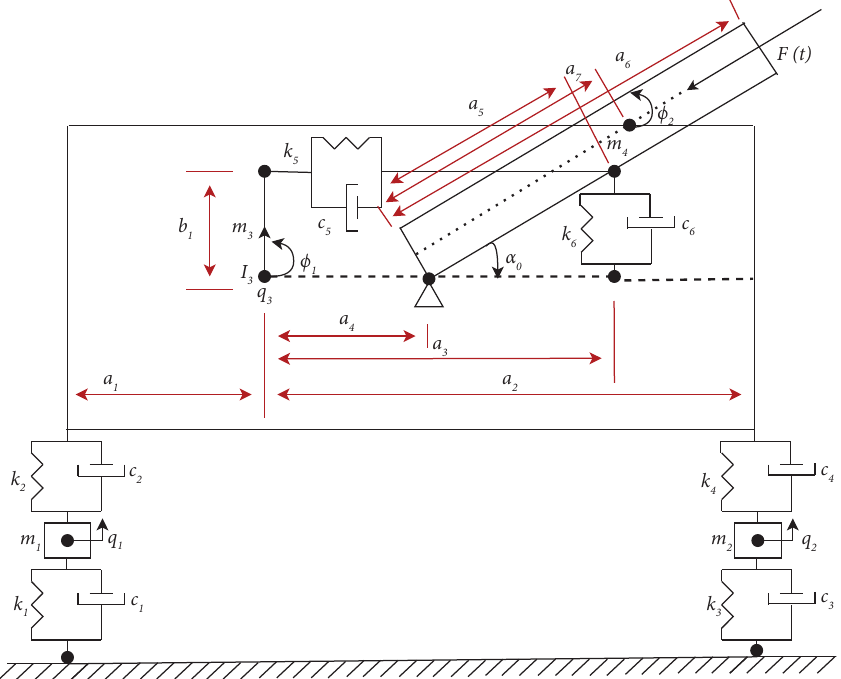
Figure 1: Dynamic model of the very short-range